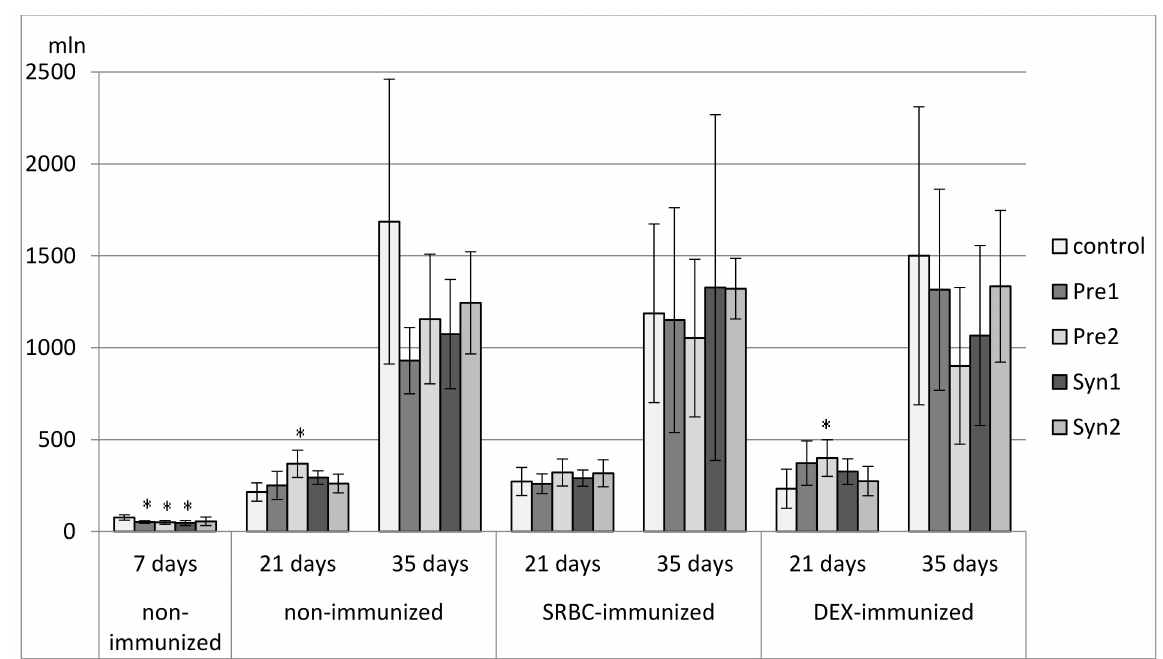
Figure 11. The total count of CD8 + cells in the spleen of chicken broilers after in ovo injection of the investigated prebiotics or synbiotics. The data are expressed as the mean ± SD. Data with a symbol (*) denote a significant difference with respect to the control group ( p < 0.05).